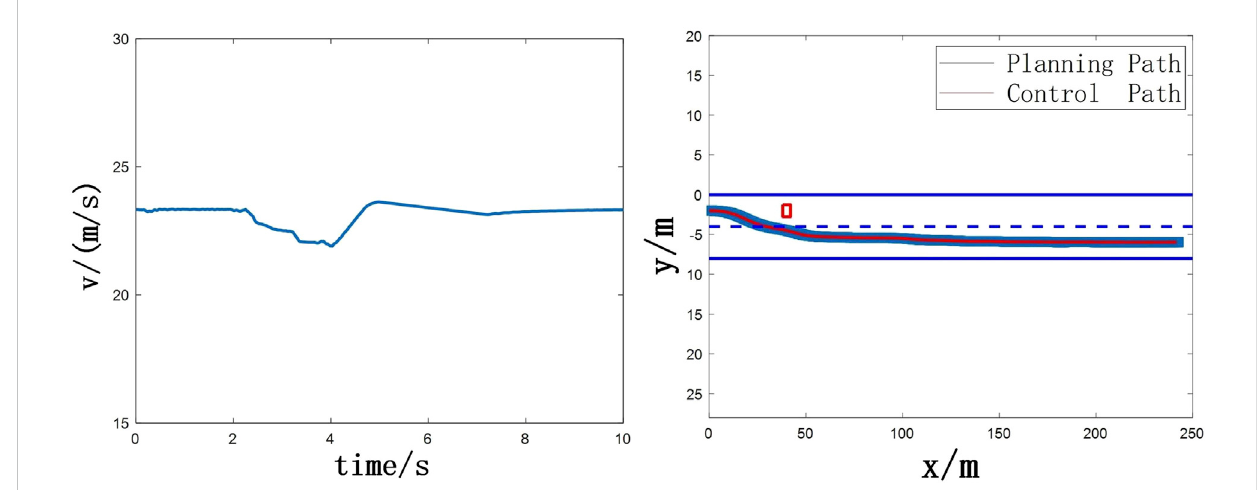
FIGURE 12 (A) Vehicle speed (B) Obstacle avoidance